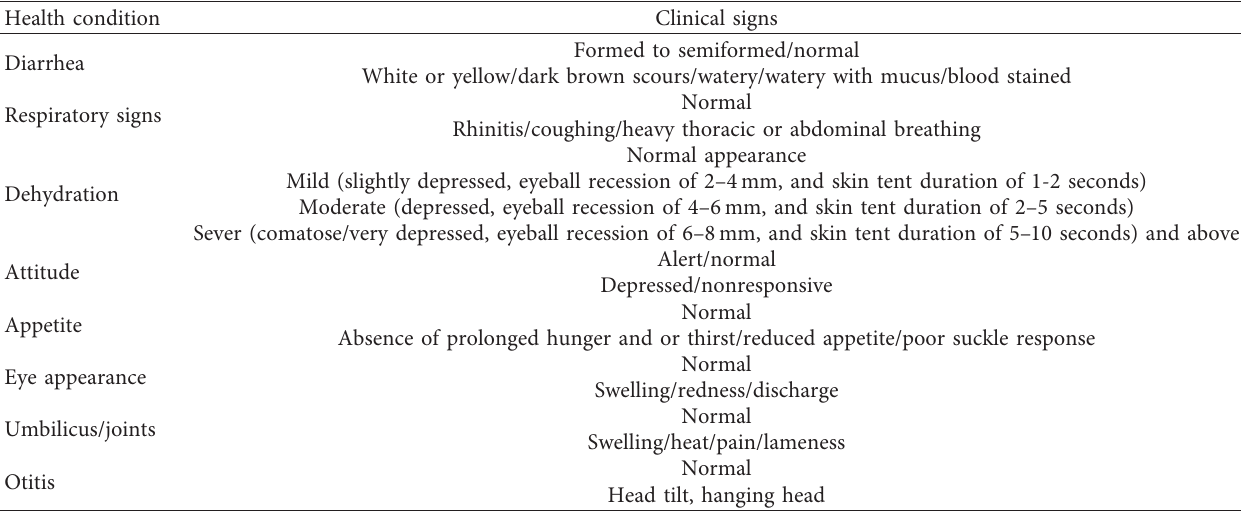
Table 1: Criteria for designating a calf to either normal or with morbidity indicator